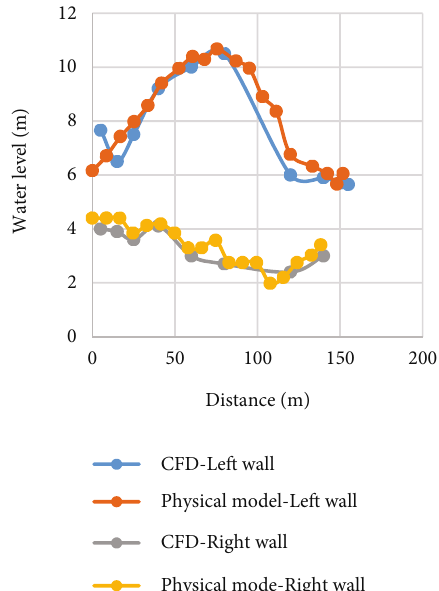
Figure 15: Comparison of the water surface for the sidewalls between the experimentation and the numerical methods.